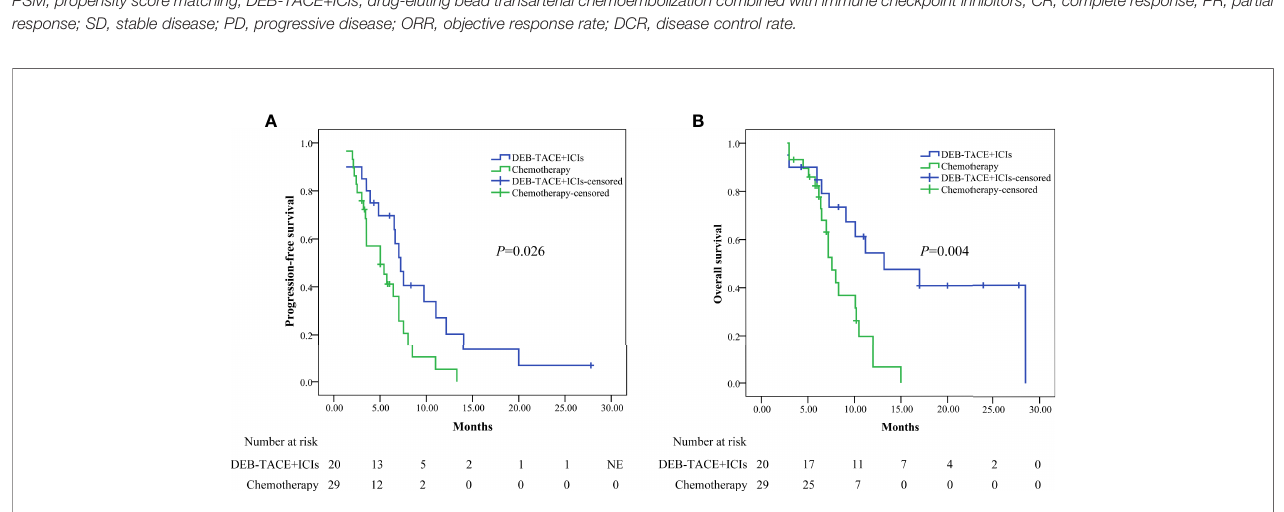
FIGURE 2 | Kaplan-Meier analyses of progression-free survival (A) and overall survival (B) in the two groups before PSM. DEB-TACE+ICIs, drug-eluting beads transarterial chemoembolization combined with immune checkpoint inhibitors; PSM, propensity score